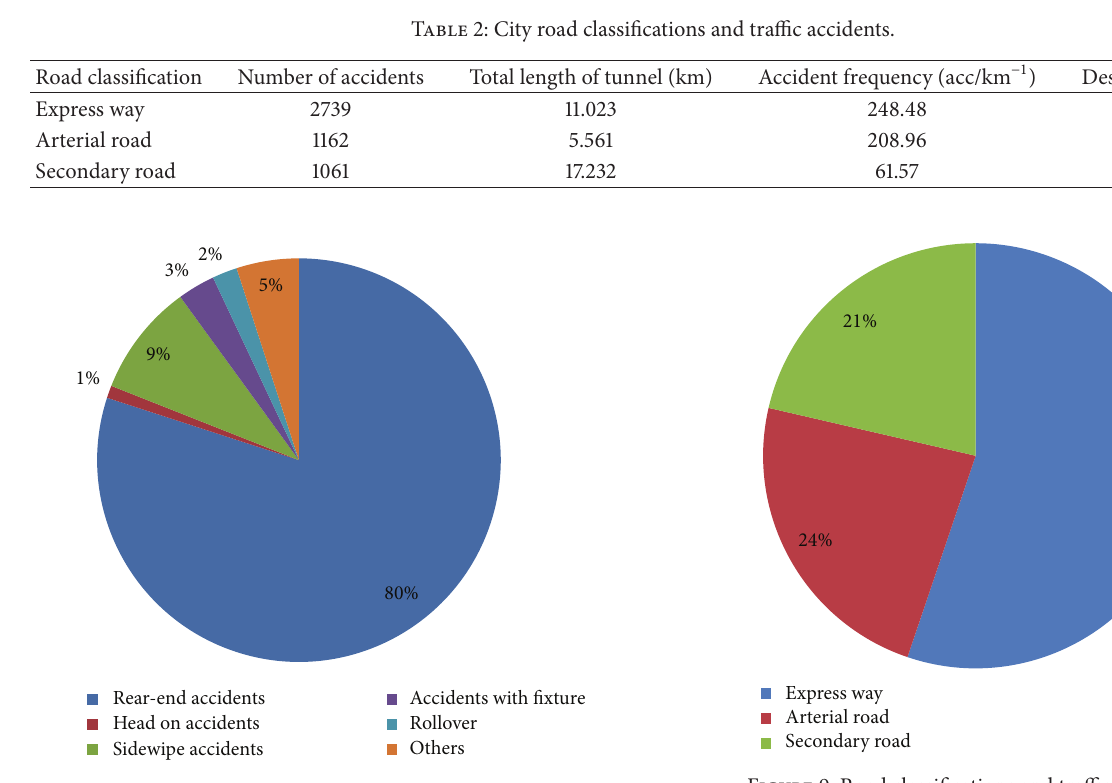
Figure 8: Accident types versus traffic accidents. Figure 9: Road classifications and traffic